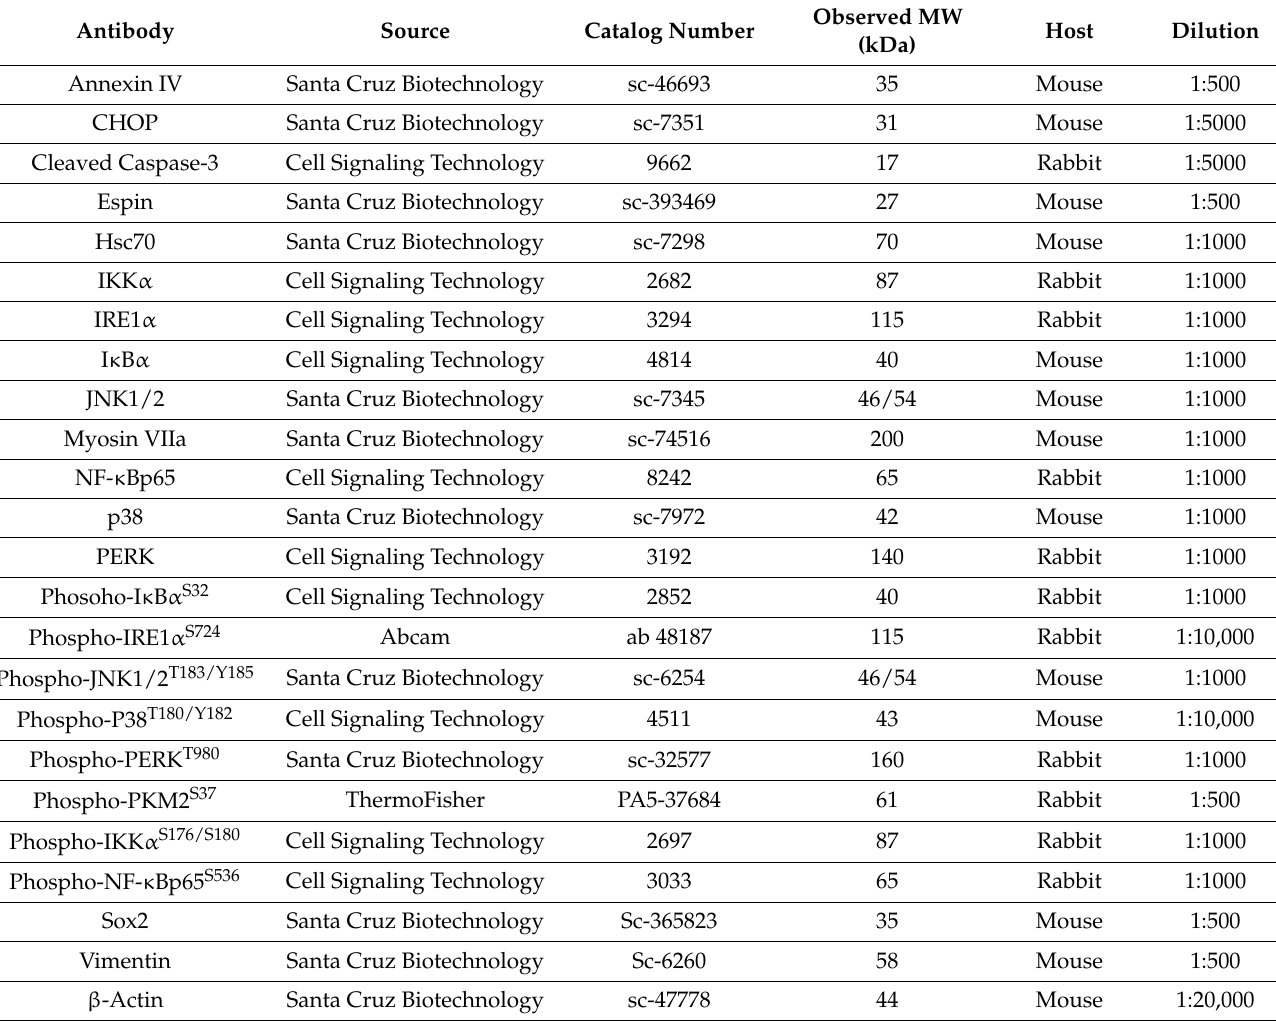
Table 1. List of antibodies used in the reported